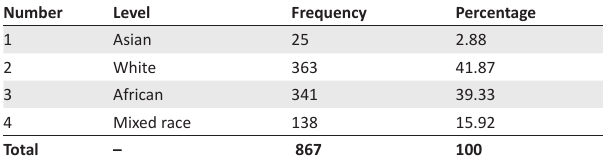
TABLE 5: Racial (population) distribution.